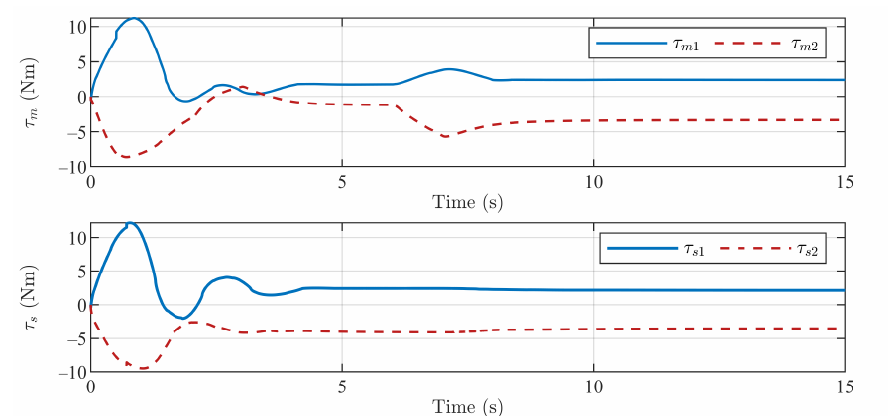
Figure 7. The control values of the master and slave controllers.